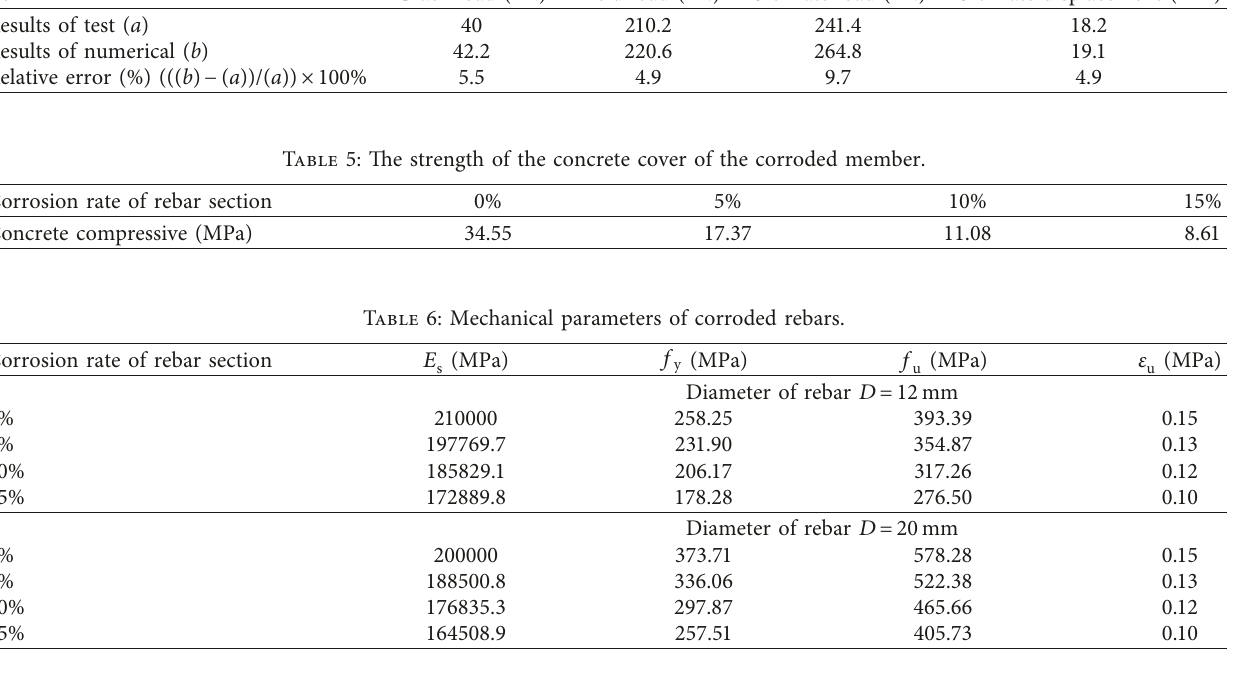
Table 7: The degradation of bonding